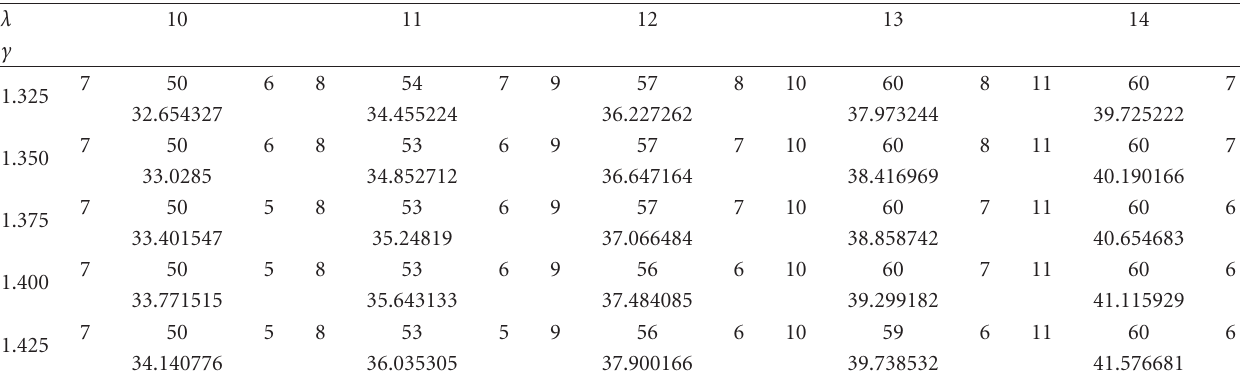
Table 2: Optimal values corresponding to various demand rates and perishable rate ( β = 1 . 3, α = 4, μ = 4, p = 0 .